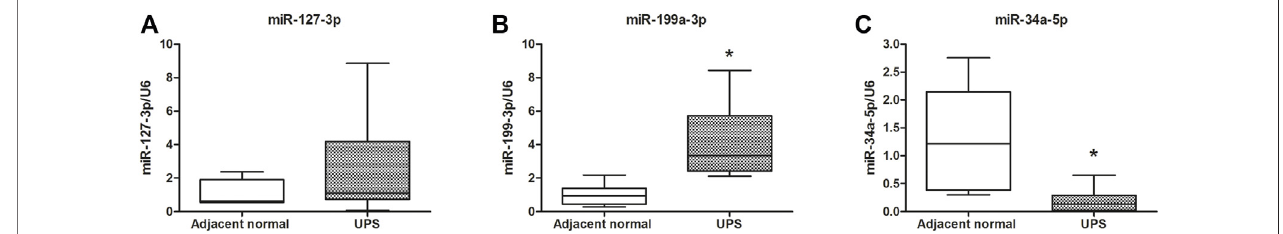
Frontiers in Genetics |